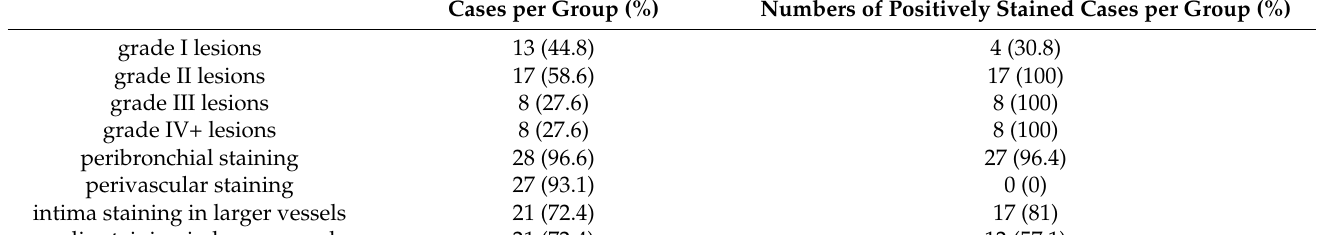
Table 4. S100A4 expression Heath–Edwards lesions and iPAH lungs ( n = 29). Pathological vascular lesions classified according to Heath–Edwards [9,10] as well as perivascular and peribronchial expression were analyzed.